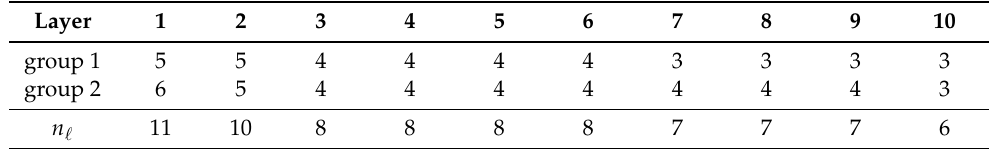
Figure 9. The singular values for groups 1 (upper) and 2 (lower) associated with the scalar flux solutions (snapshots) from local proper orthogonal decomposition. The values have been normalised by the largest singular value. Table 4. The number of basis functions selected for a tolerance of